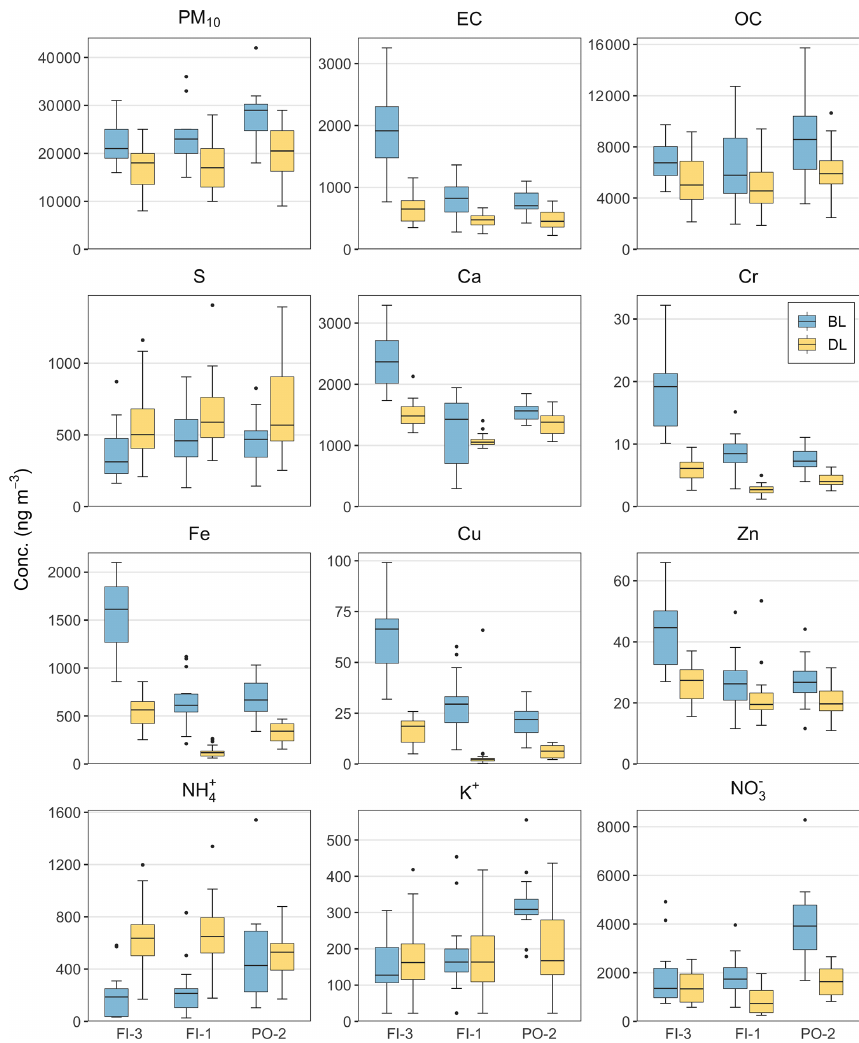
Figure 7. Comparison between the period before the lockdown (BL) and during the lockdown (DL) for the main chemical markers for each of the three sites. Boxes represent the interquartile range (IQR; between the 25th and 75th percentile) and the median (line inside the boxes), whiskers cover the range of the samples over and under 1 . 5 · IQR, and the points are